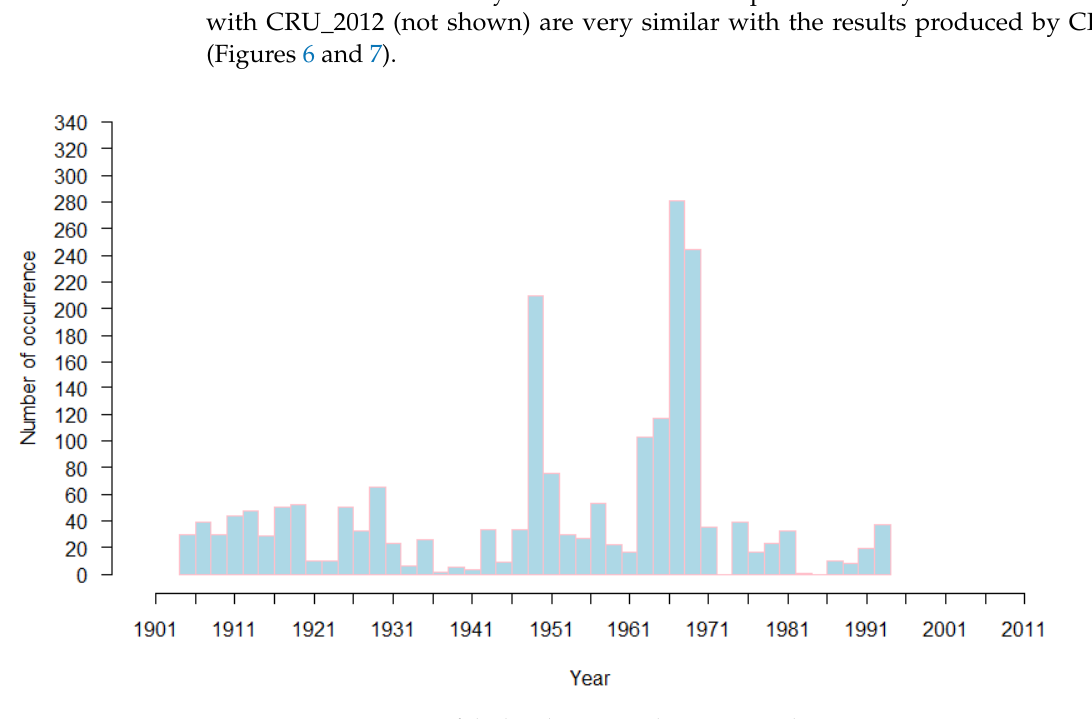
Figure 6. Histogram of the break years with CRU_1995 data.